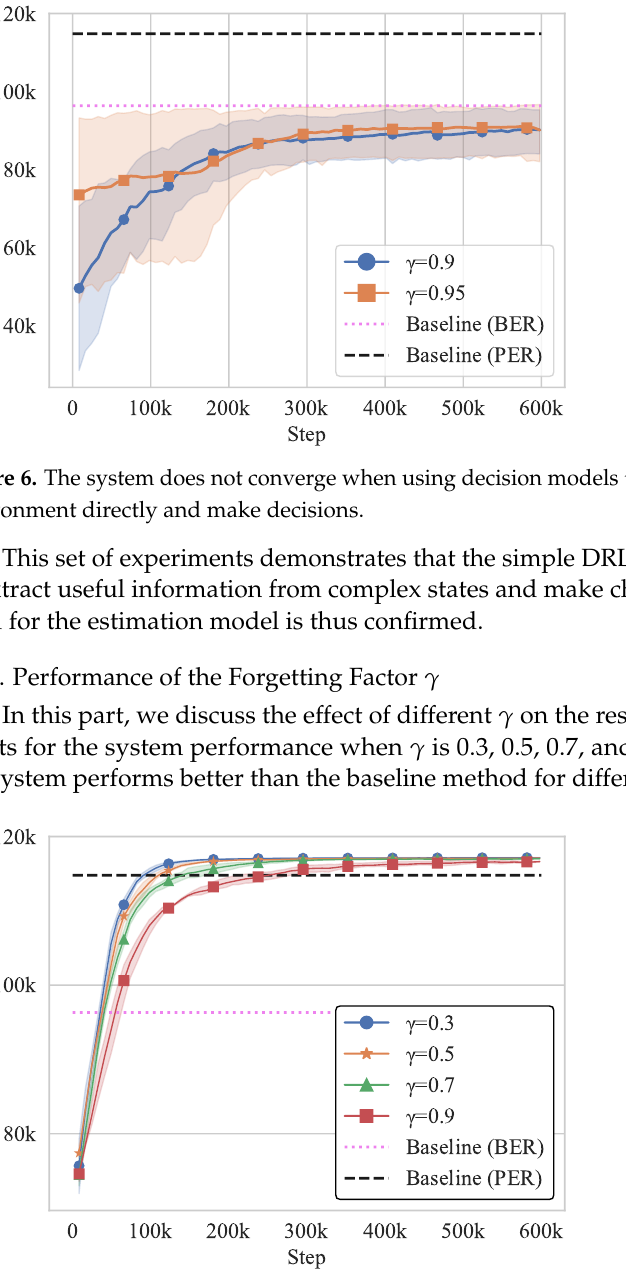
Figure 7. System converges under different γ and throughput improves with the adoption of the estimation